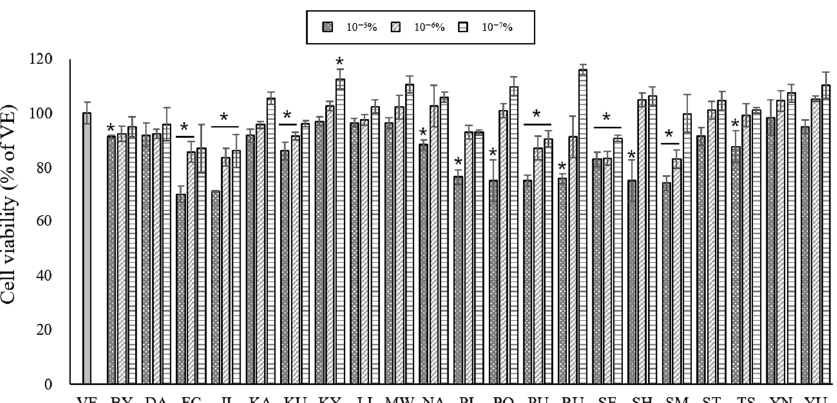
Figure 2. Cell viability assessed by CCK assay. Values are presented as means ± standard deviations. Note: * p < 0.05 compared to VE. VE, vehicle group; BY, C. platymamma ; DA, C. maxima ; FC, C. medica ; JI, C. sunki ; KA, C. X aurantium ; KU, C. japonica ; KY, C. unshiu X C. sinensis ; LI, C. limon ; MW, C. reticulata ; NA, C. X aurantium ; PL, C. X latifolia ; PO, C. reticulata ; PU, C. maxima ; RU, C . paradisi ; SE, C. X aurantium